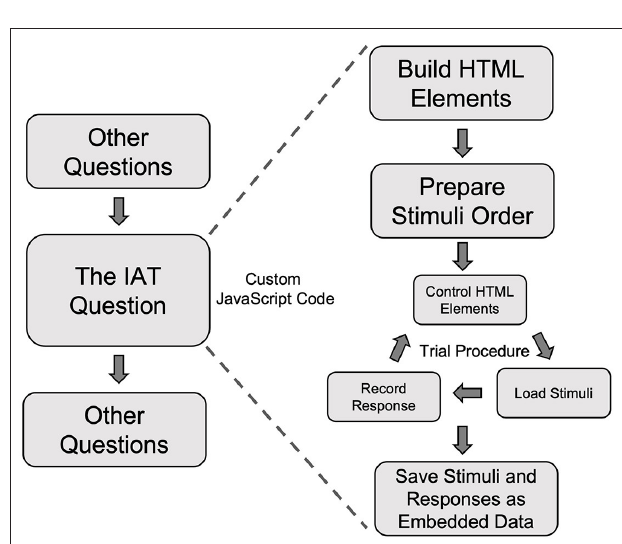
FIGURE 5 | A schematic flow of using custom JavaScript code to create the Implicit Association Test in a Qualtrics survey. IAT, Implicit Association Test.